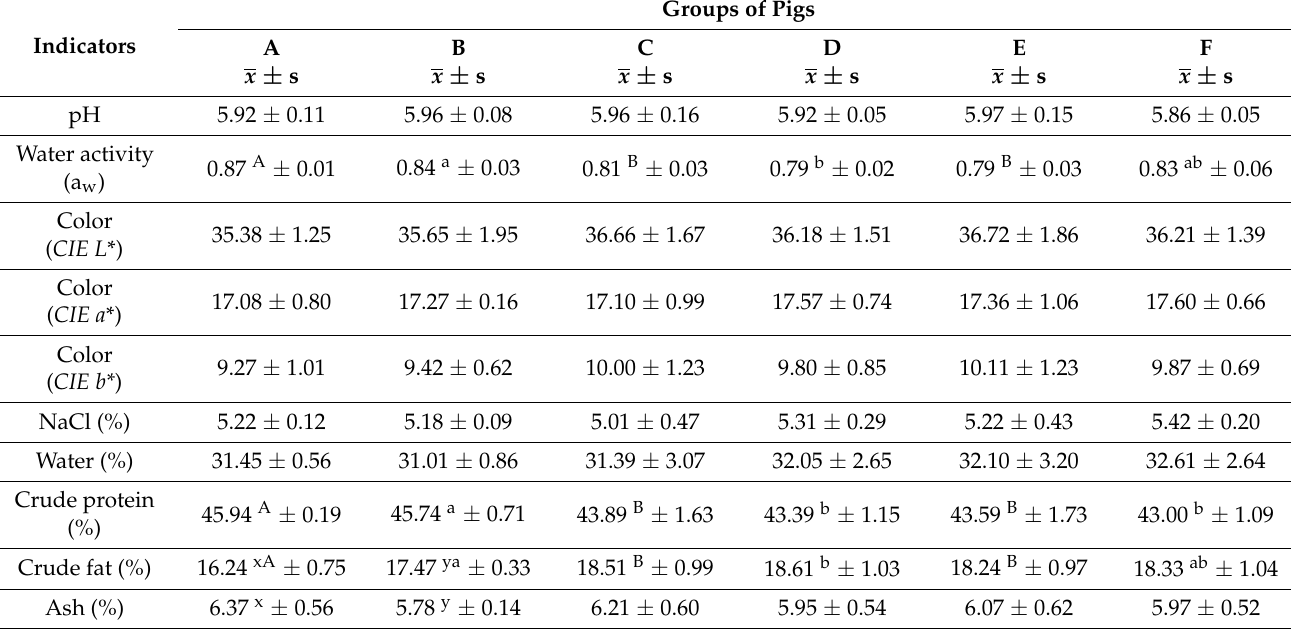
Table 11. Physical and chemical properties of